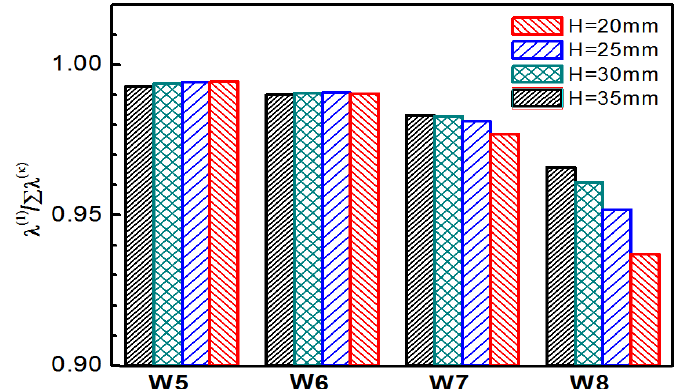
Figure 4. Contribution to total energy of the first order POD mode.